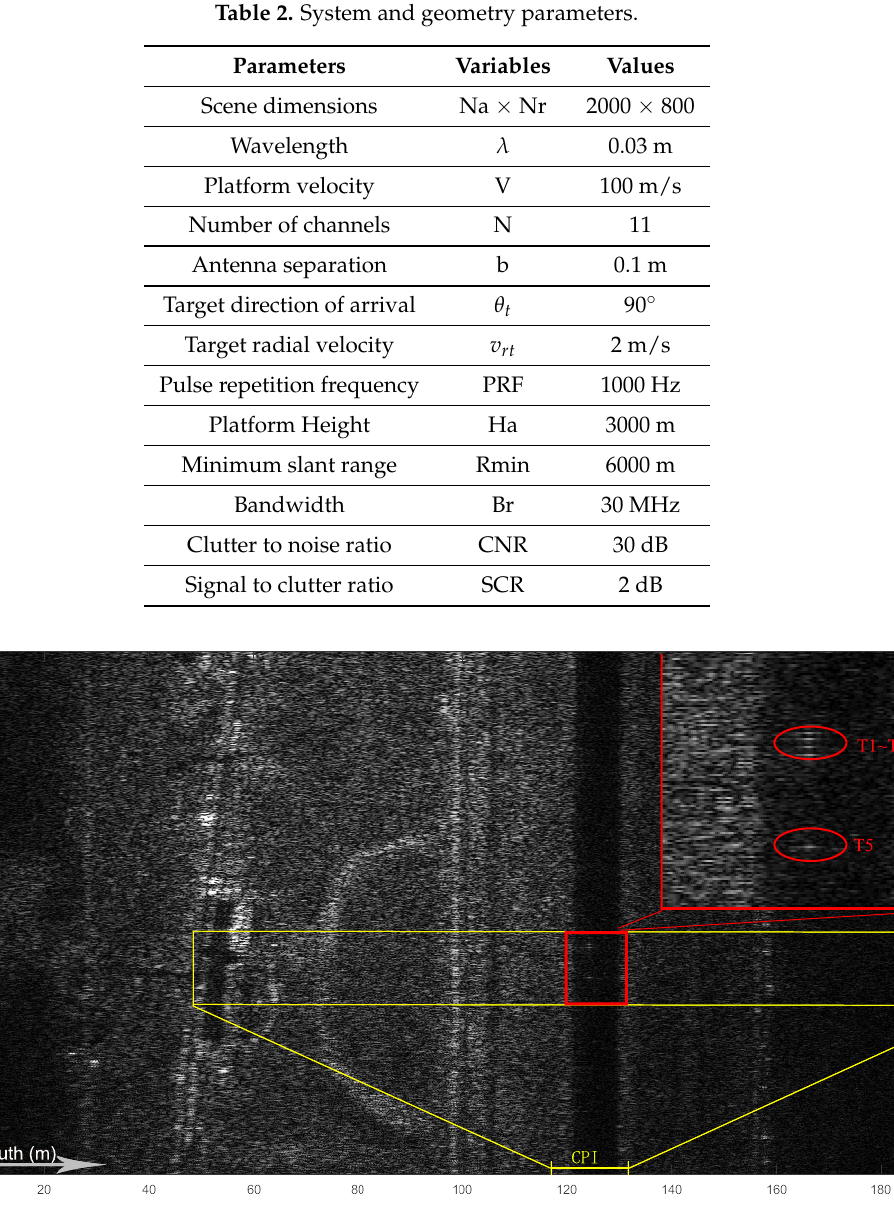
Figure 7. SAR scene with five injected